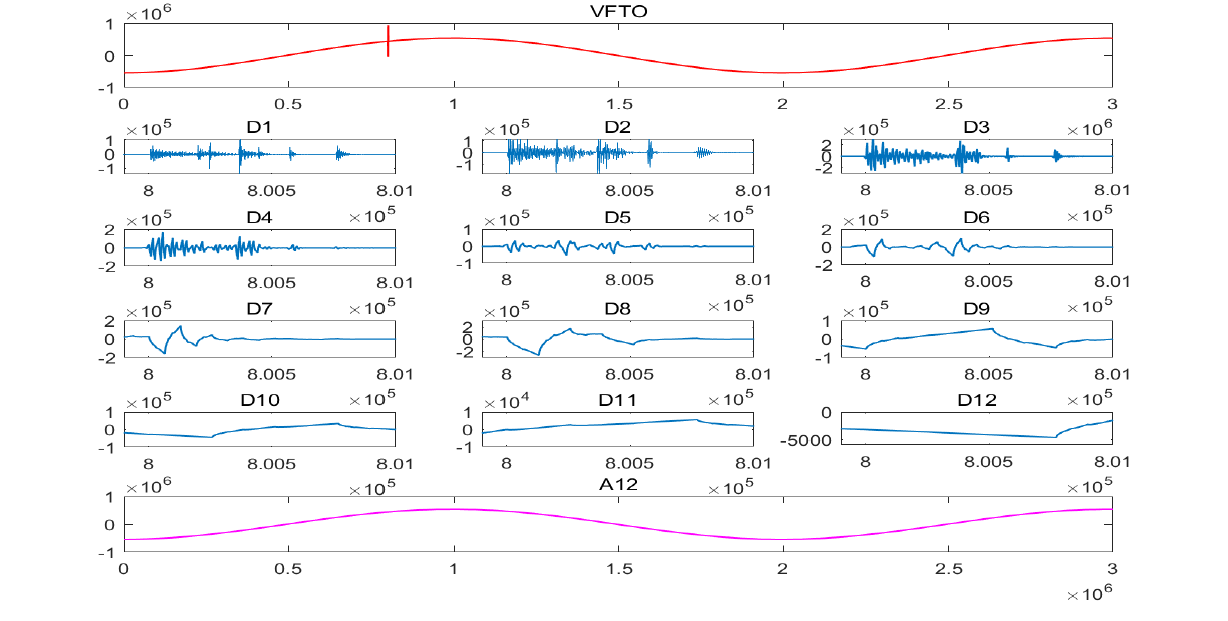
Figure 7. VFTO wavelet decomposition results of power supply side. The detailed coefficients D i ( i = 1, 2, · · · , 12 ) of the 12-layer wavelet were obtained by VFTO wavelet decomposition, and the VFTO feature matrix A was constructed according to Equation (2). Then, the SVD of the feature matrix A was carried out to obtain the six-order singular values of VFTO from the power side and the load side, as shown in Figure